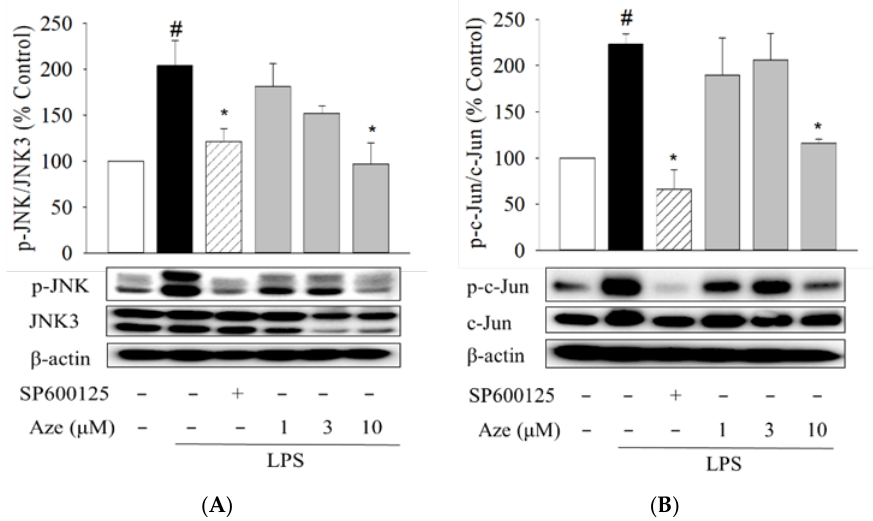
Figure 3. Aze inhibited the LPS-induced phosphorylation of JNK and c-Jun in BV2 cells. Cells were co-treated with LPS (1 μg/mL) and SP600125 (10 μM) or the indicated concentrations of Aze for 24 h. Control cells were treated with vehicle only. Cell lysates were then prepared and analyzed by western blotting using anti-phospho-JNK (p-JNK) and JNK3 antibodies ( A ) or anti-phospho-c-Jun (p-c-Jun) and c-Jun antibodies ( B ). β-Actin was used as a loading control. Representative blots are shown. Data are presented as the mean ± SEM from three independent experiments. # p < 0.05 and * p < 0.05 vs. vehicle-treated control and LPS-treated cells, respectively.